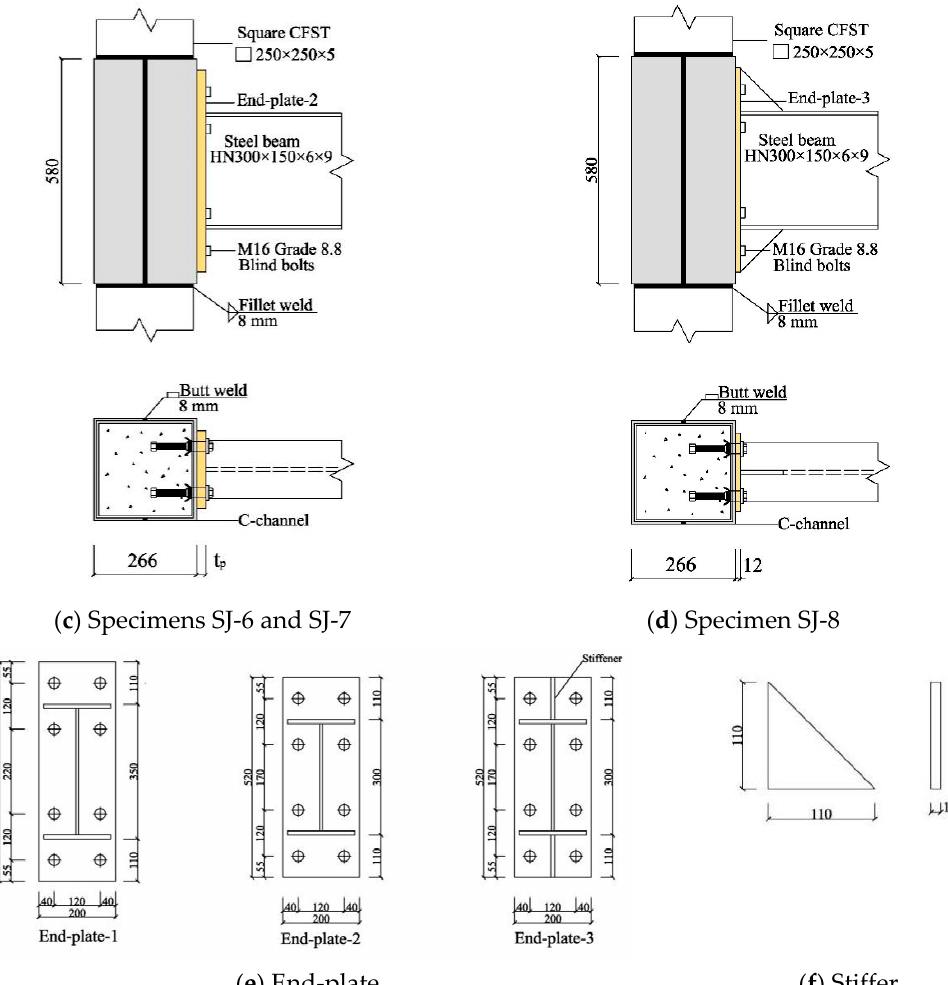
Figure 2. Details of the joint specimens.